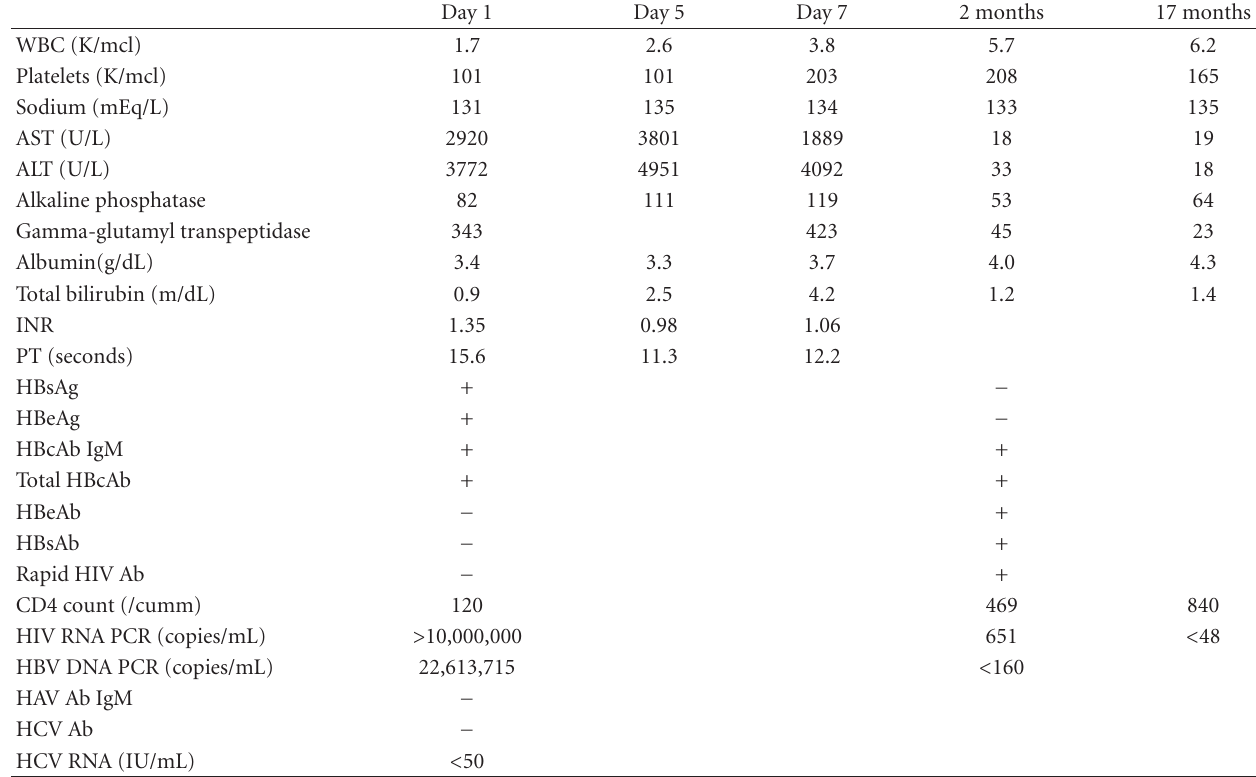
Table 1: Laboratory